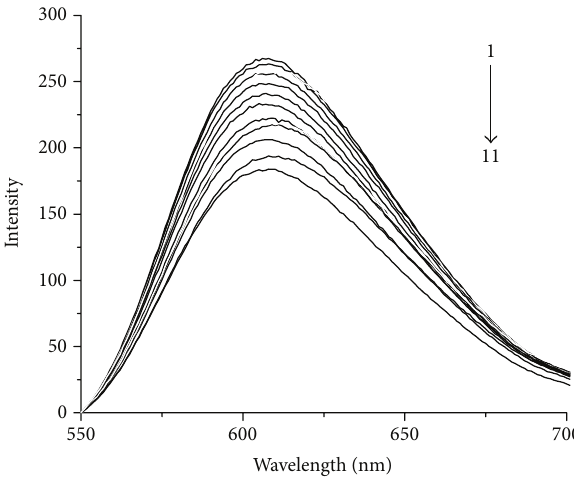
Figure6:FluorescencespectraofEB-DNA1titratedbyZNF191(243- 368). 𝐶 DNA = 0.5 𝜇 mol ⋅ L −1 , 𝐶 EB = 1 𝜇 mol ⋅ L −1 , from up to down, and 𝐶 protein /𝐶 DNA = 0, 0.1, 0.2, 0.3, 0.4, 0.5, 0.6, 0.7, 0.8, 0.9, 1.0, respectively.